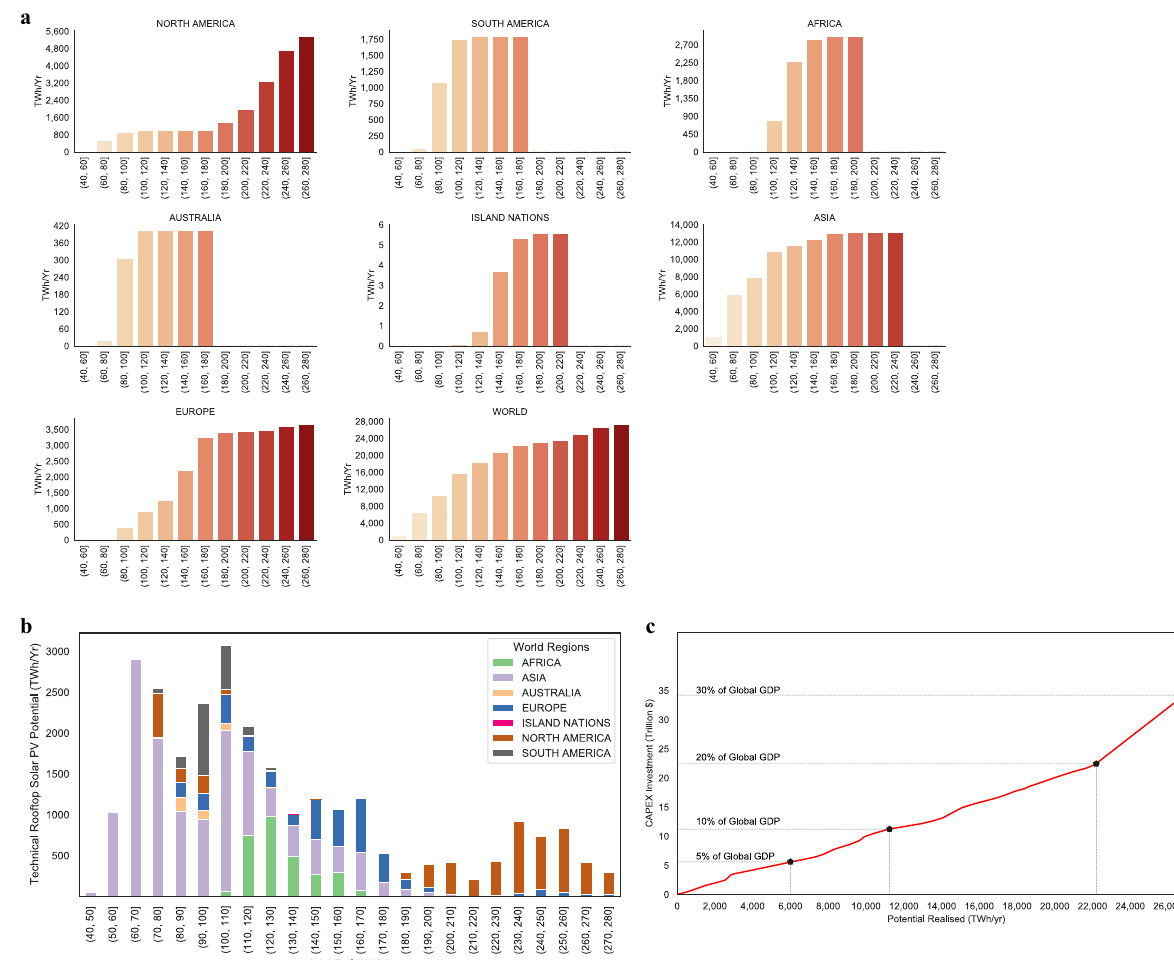
Fig. 7 Regional supply cost curves based on a 20 $/MWh bin size and distribution of LCOE across regions. Regional Supply cost curves ( a ), showing the cumulative technical potential for a given LCOE bin size. The absolute increase in the bar height represents the change in the added potential that can be realized in a given LCOE bin. Near constant bar heights for consecutive bins are representative of a very small additional potential being realized at an increasing cost. For a single bar, the height of the bar represents the cumulative potential that can be realized within a speci fi c LCOE band. b Distribution of potentials across LCOE bins of 10 $/MWh size. Potential extraction is the cheapest in Asia, followed by Africa and Europe. c CAPEX investment required to achieve a speci fi c total potential as a percentage of global GDP in 2015. Nearly 50% of global potential can be achieved at investment equivalent to 15% of 2015 global GDP